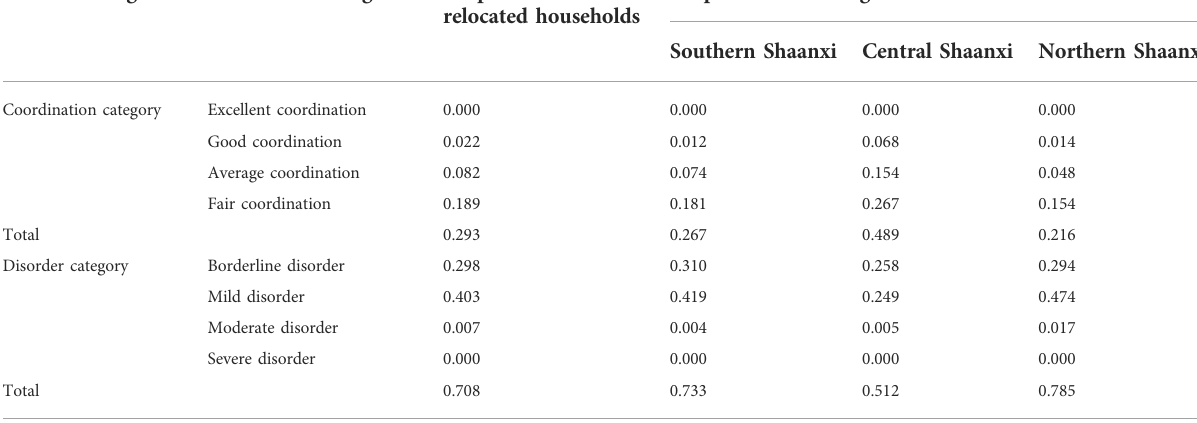
TABLE 6 Proportions of the overall and regional relocated households in strength categories of “ livelihoods – environment ” links. Division categories Subdivision categories Proportion of overall Proportion of subregional relocated households relocated households Southern Shaanxi Central Shaanxi Northern